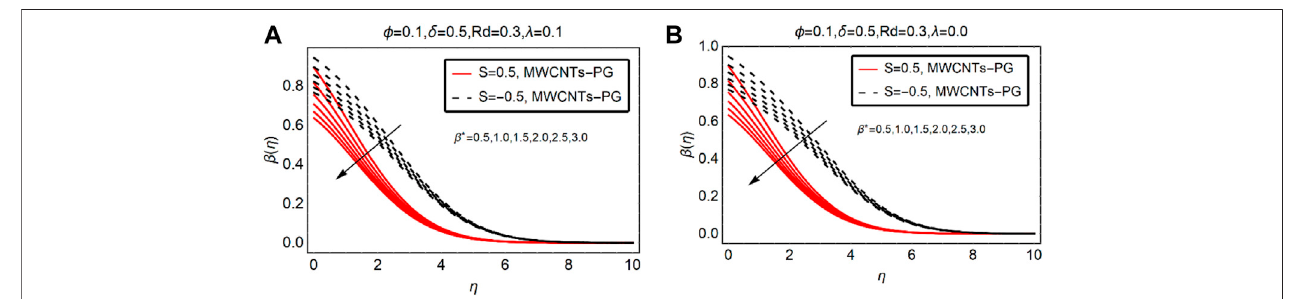
FIGURE 5 | β ( η ) against β p (A) λ > 0 and (B) λ (cid:2) 0.